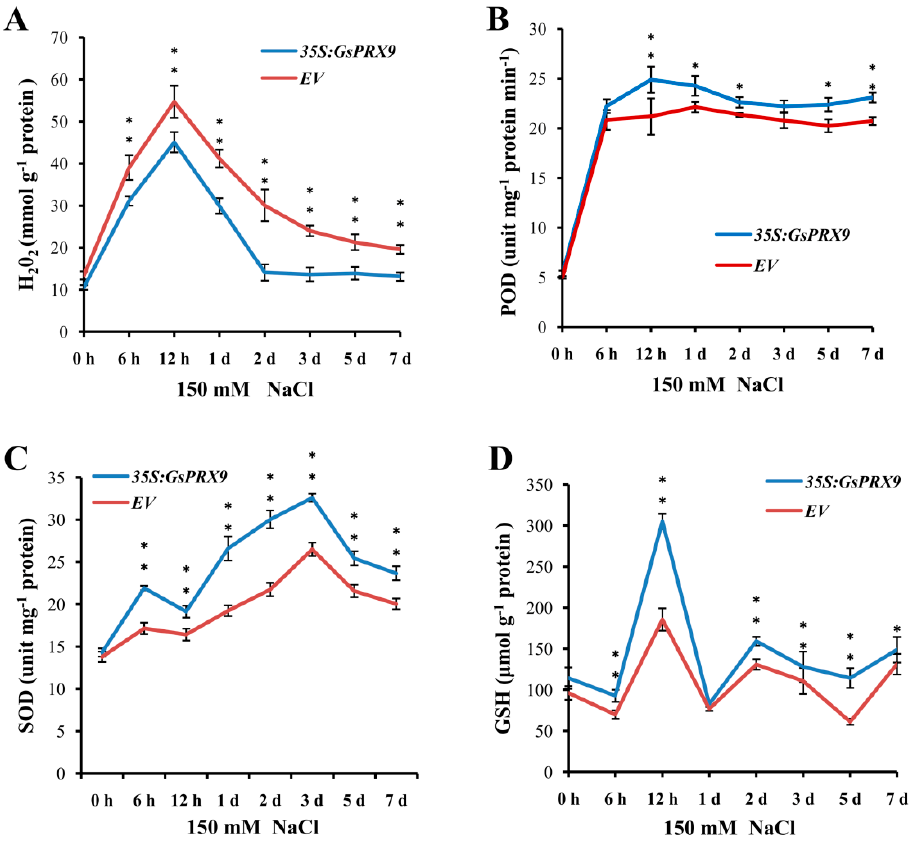
Figure 6. Effect of GsPRX9 overexpression on H 2 O 2 content ( A ), POD activity ( B ), SOD activity ( C ), and GSH level ( D ) in transgenic soybean hairy roots under salt stress. EV represents soybean hairy roots with the empty vector pBinGFP4, and 35S:GsPRX9 represents roots with the recombinant vector pBinGFP4– GsPRX9 ( GsPRX9 was expressed in fusion with GFP, driven by a CaMV 35S promoter). The content of hydrogen peroxide (H 2 O 2 ), activity of peroxidase (POD), superoxide dismutase (SOD), and glutathione level (GSH) in soybean hairy roots were measured at 0 h, 6 h, 12 h, 1 d, 2 d, 3 d, 5 d, and 7 d after 150 mM NaCl treatment. Data represent the mean ± standard deviation of four biological replications and each repeat contained three independent transgenic hairy roots ( n = 4 × 3 = 12). * and ** represents a significant difference between EV and 35S:GsPRX9 for each time point at the 0.05 or 0.01 level by Student’s t -test, respectively.